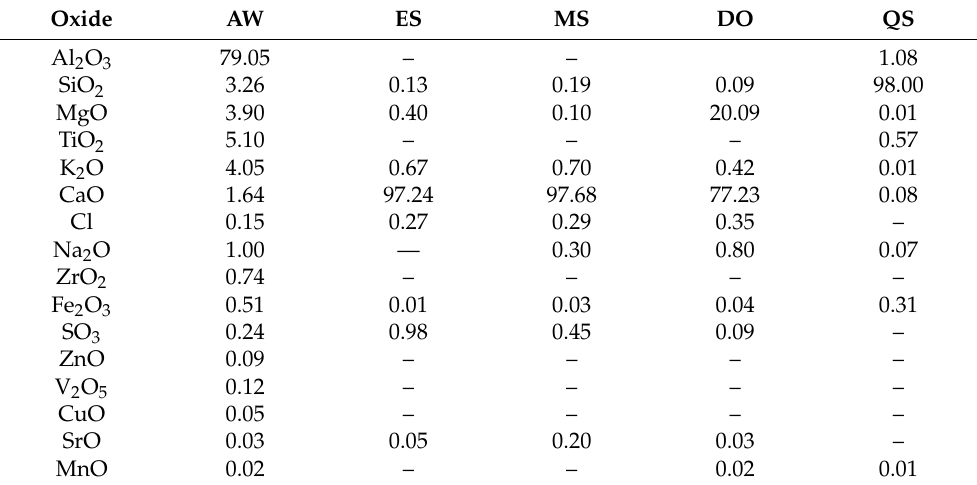
Table 2. Main chemical composition of aluminum waste (AW), eggshells (ES), mussel shells (MS), dolomite (DO), and quartz sand (QS) (expressed as wt.%) determined by X-ray fluorescence (XRF). (Standard deviation (SD) 0.02